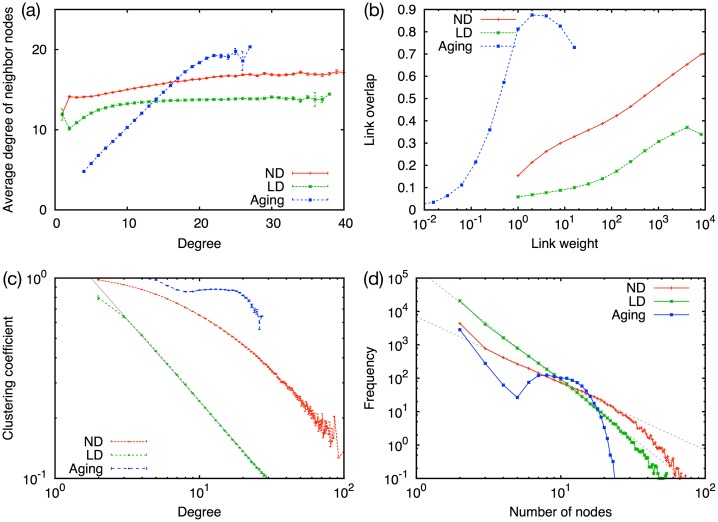
Relations of various network characteristics.(a) Average degree of neighboring nodes as a function of degree, (b) link overlap as a function of link weight, (c) local clustering coefficient as a function of degree, and (d) community size distribution for the ND, LD, and aging models. In (c) a fitting line corresponding to x
−0.82 is also shown. In (d) communities are identified using the link community detection method. Fitting by power laws with exponent −3.4 and −2 are shown as guides to the eyes.